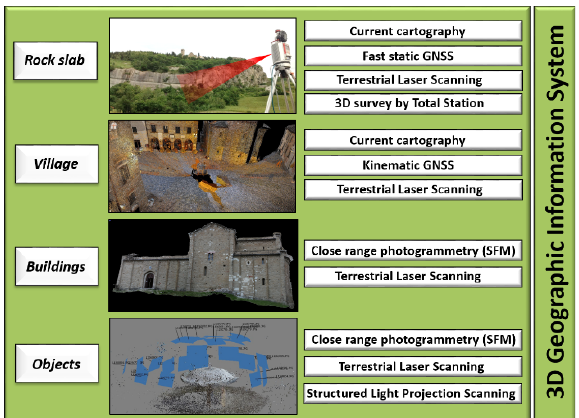
Figure 1. Scheme of the geomatic techniques applied at different scales of investigation in San Leo